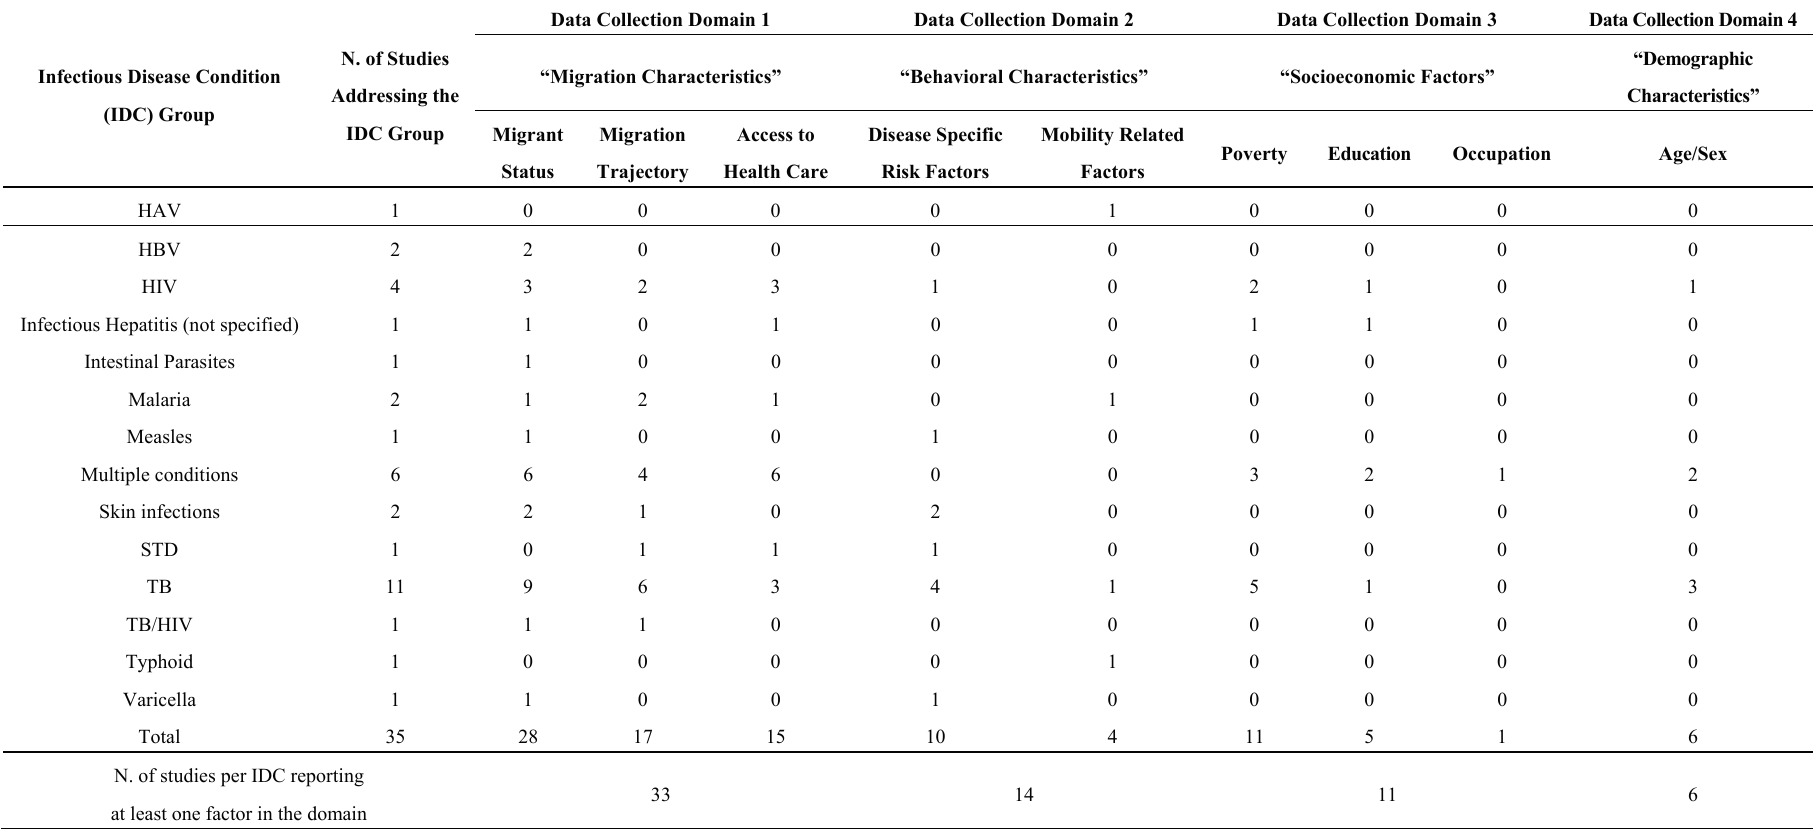
Table 3. Factors linked with increased risk for specific Infectious Disease Condition groups in